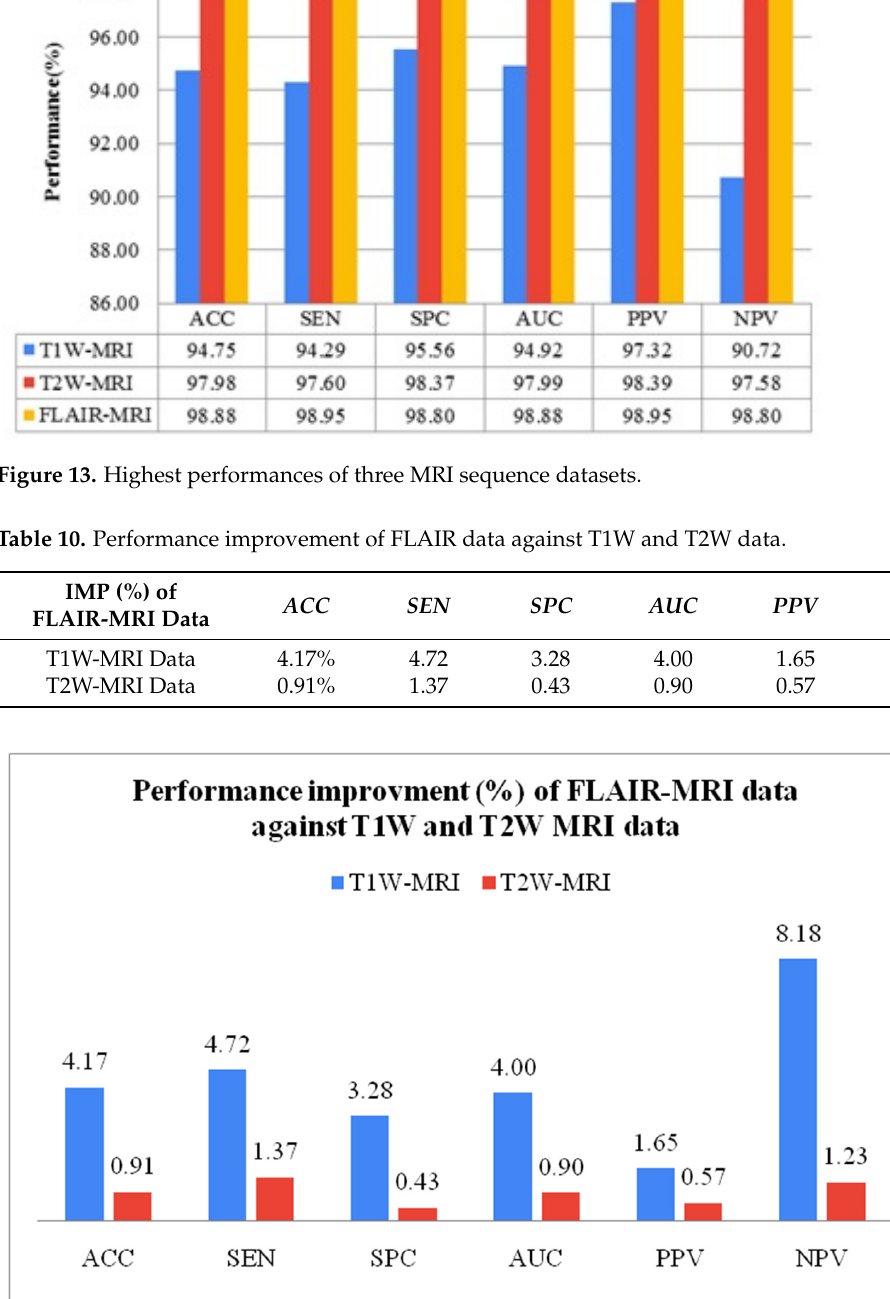
Figure 14. Performance improvement of FLAIR-MRI data against T1W and T2W-MRI data.